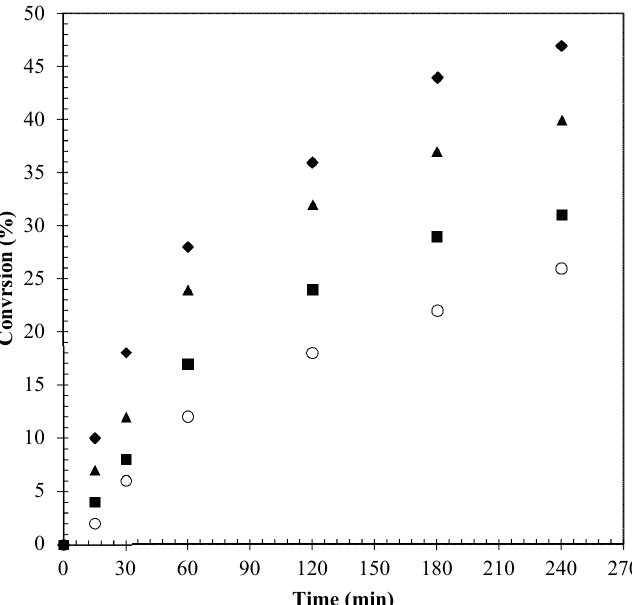
Figure 7. Effect of mole ratio of glycerol to benzyl alcohol. Speed of agitation: 1000 rpm, catalyst loading 0.03 g/cm 3 , temperature: 150 °C, reaction duration: 4 h. ( ) 01:01; ( ) 01:02; ( ) 01:03; ( ) 1:4.